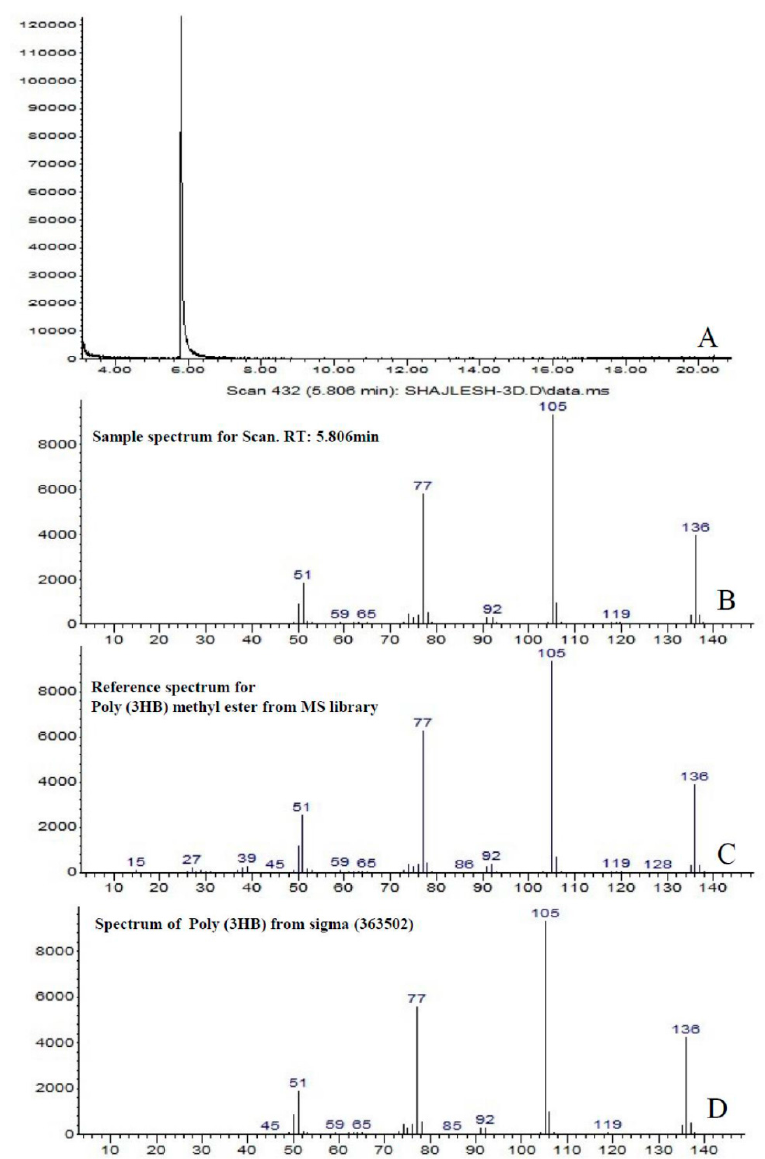
Figure 7. Gas Chromatography–Mass Spectrometry (GC–MS) analysis of biopolymer obtained from co-culture of Sde 2-40 and B. cereus. ( A ) Ion chromatogram; the peaks at 5.806 min are 3-hydroxybutyric acid methyl ester (3HB-Me); ( B ) Mass spectrum for the sample; ( C ) Reference mass spectrum for 3HB-Me from the MS library; ( D ) Mass spectrum of the commercial poly(3-hydroxyburyrate) (PHB) (Sigma 363502). The presence of the ions 51, 77, and 105 in the sample indicates PHB synthesis.